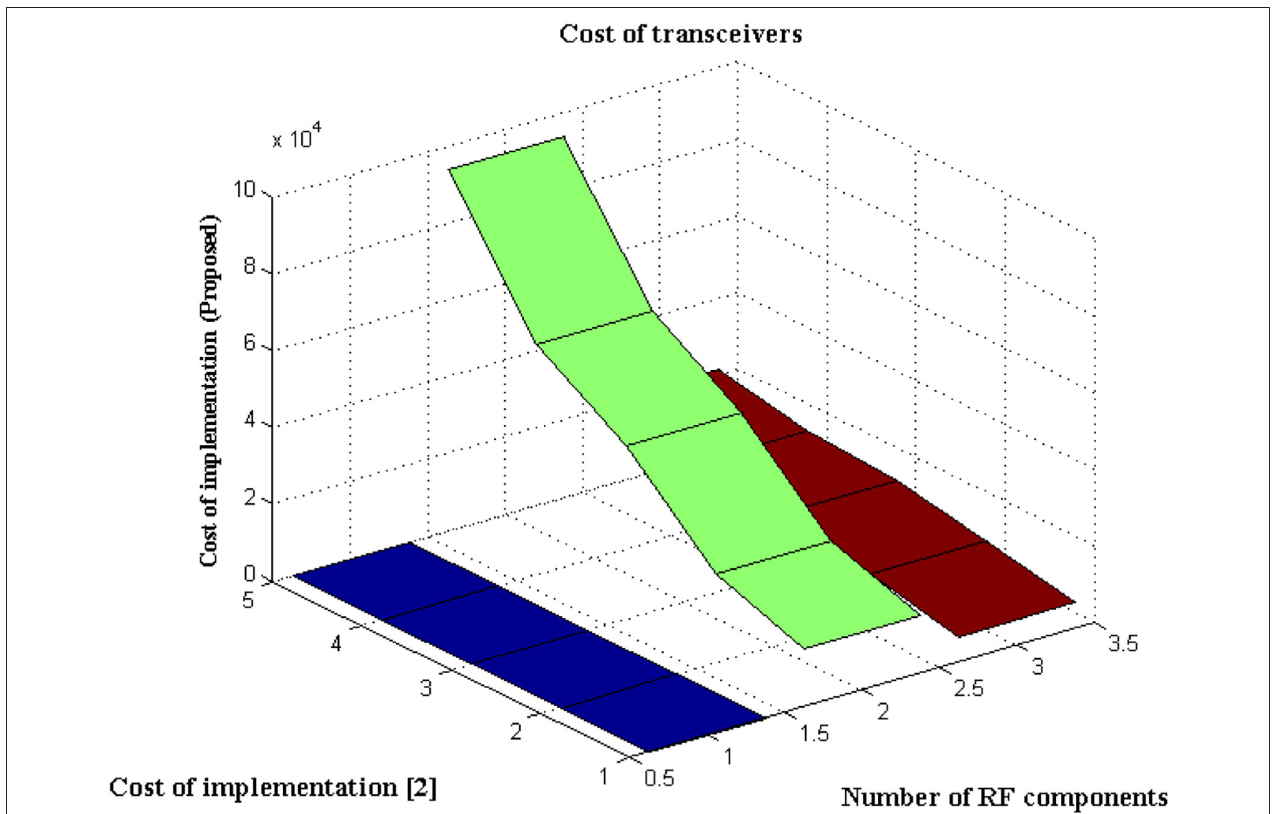
FIGURE 6 | Implementation cost.